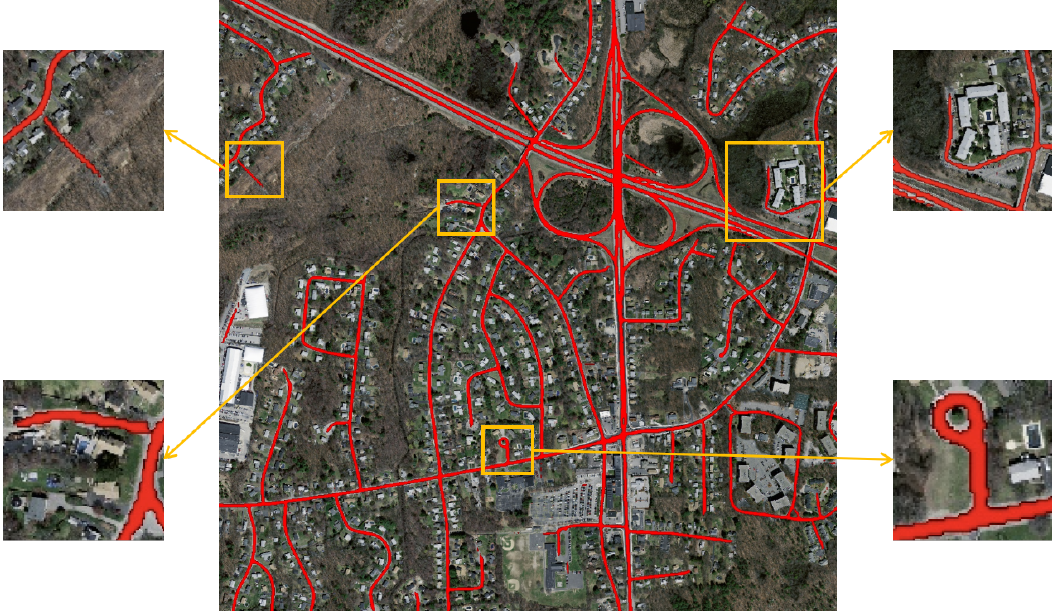
Figure 13. The visualized segmentation results of the lightweight network with an image from the Massachusetts Dataset. The four images on the left and right are the enlarged renderings of the